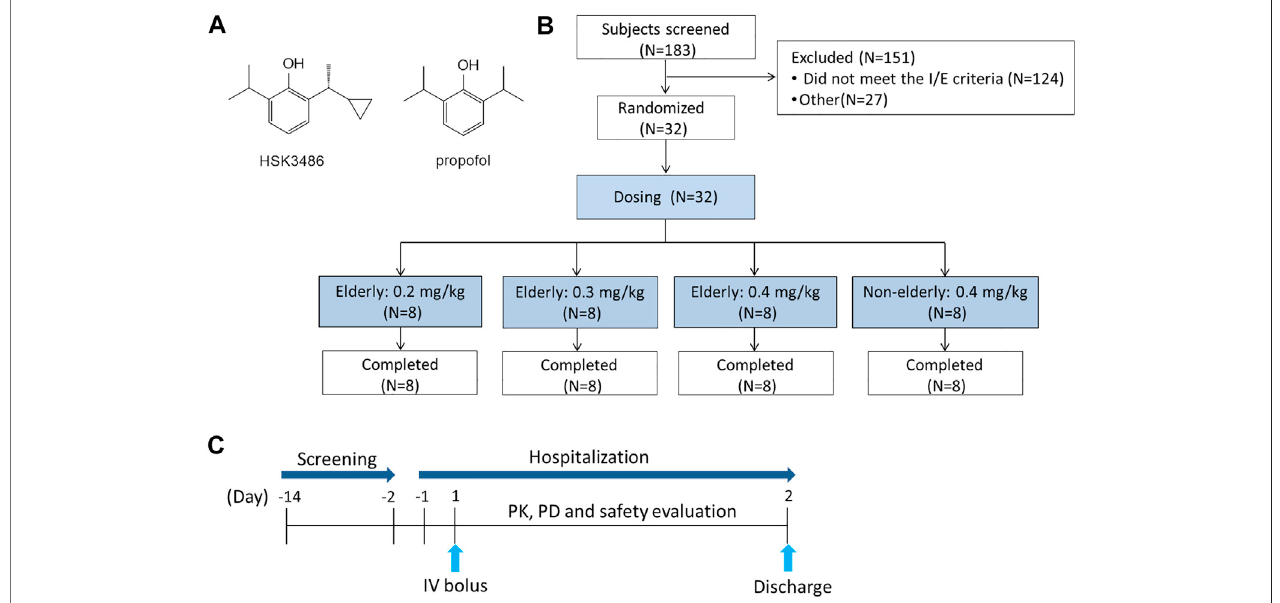
FIGURE 1 | Relevant schematics. (A) Chemical structures of HSK 3486 and propofol. (B) Study design. (C) Flow chart of the study.